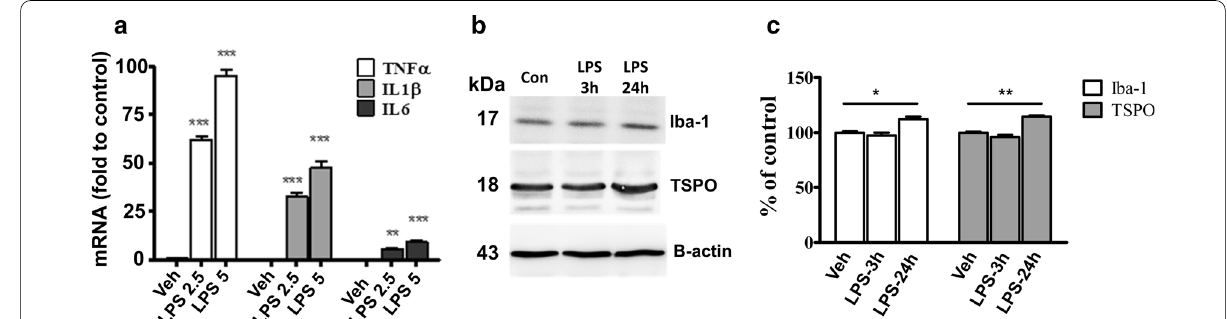
Fig. 8 a Cytokine mRNA expression levels of TNF‑α, Il‑1β and Il‑6 in the brain tissues 24 h after LPS injection. b the levels of Iba‑1 and TSPO at 3 and 24 h after injection of 5 mg/kg LPS determined by immunoblots, c Quantitative analysis of protein levels of immunoblots. Data are mean ( n 3 mice per group); * p < 0.05, ** p < 0.01, *** p < 0.005 =